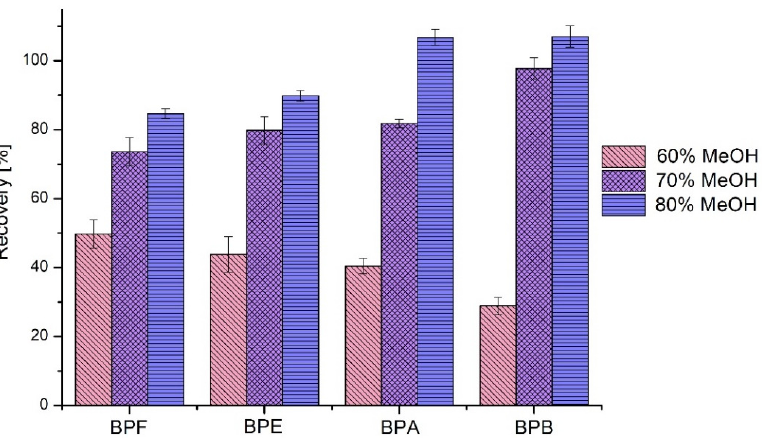
Figure 3. The recovery obtained for a 5-time preconcentration of 50 µg·L − 1 mixture of four bisphenols with each of the elution mixture (different ratio of methanol and water). Data are means with RSD ( n = 3). ( n =